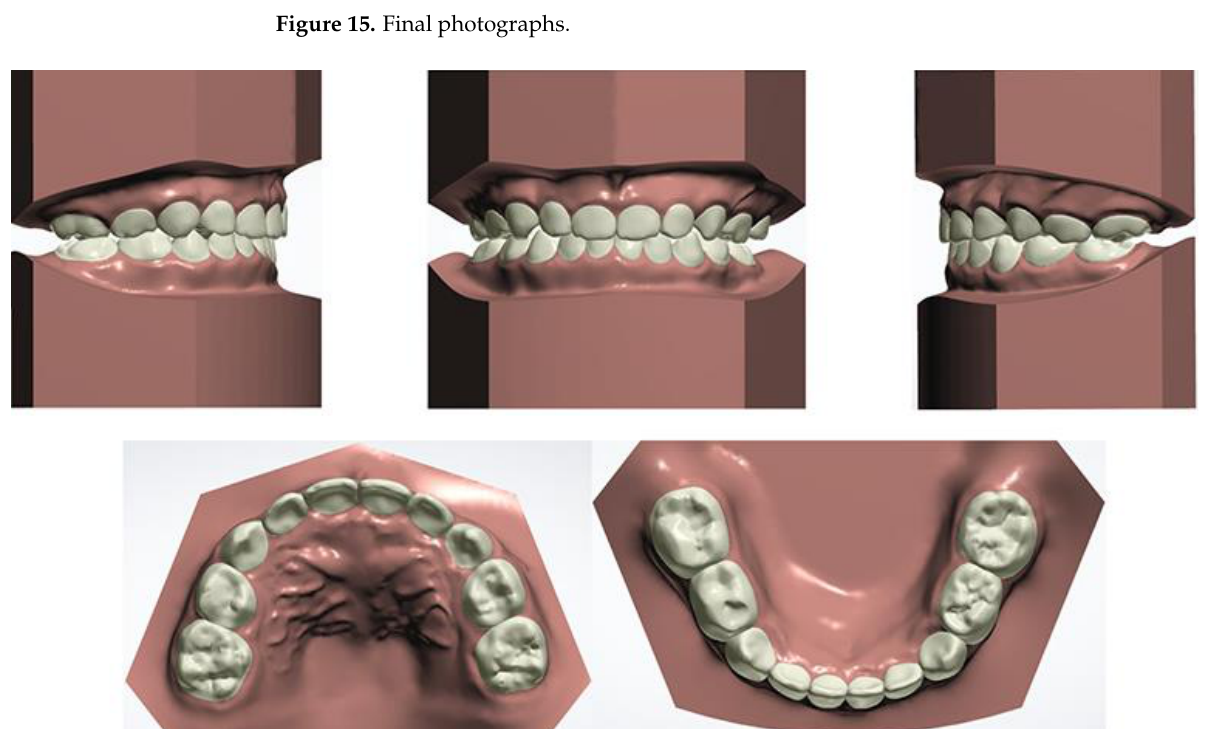
Figure 16. Final digital study models.